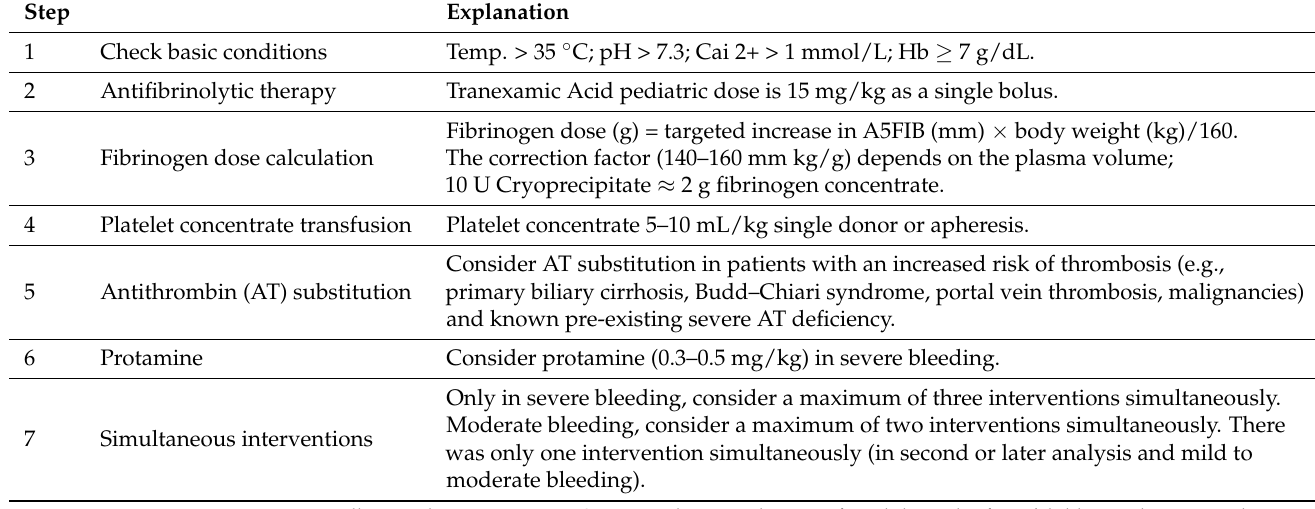
Table 3. Evidence-based parameters for ROTEM A5.Pediatric liver